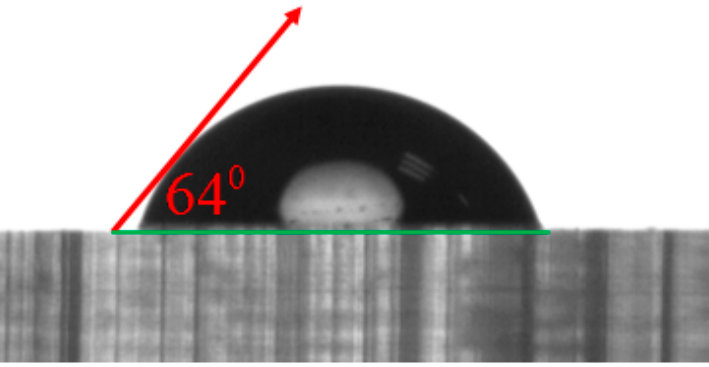
Figure 3. Measured intrinsic contact angle of the PMMA surface.